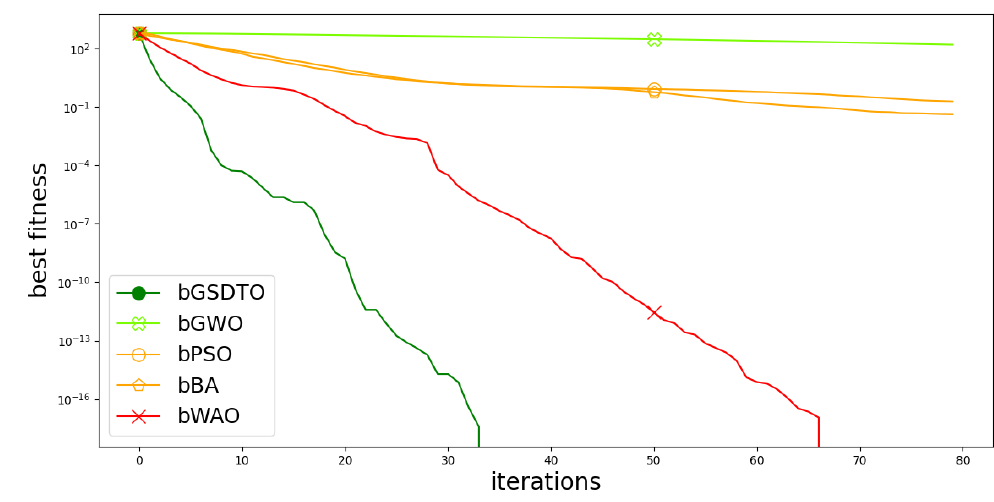
Figure 4. Feature selection comparison of the presented and compared algorithms based on convergence curve.